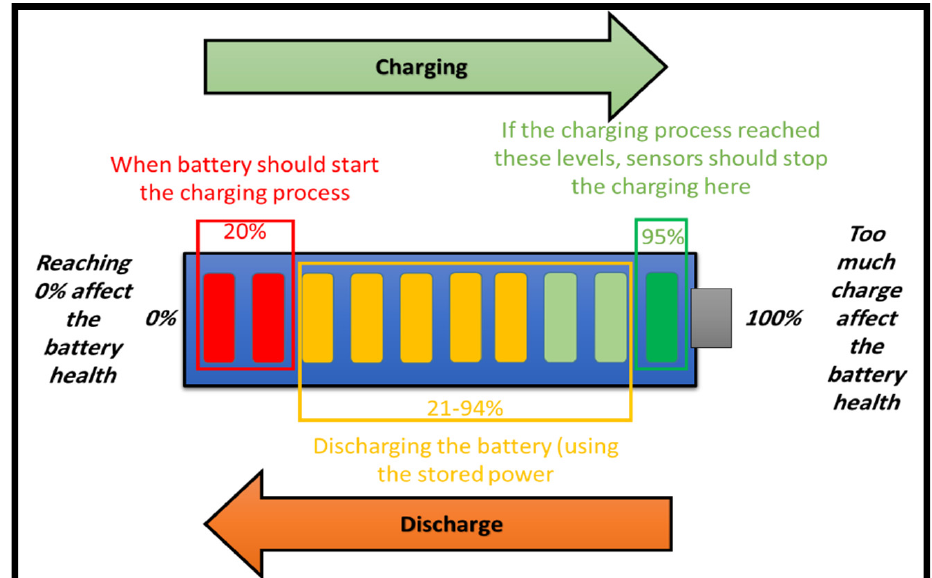
Figure 4. State of charge (SoC).